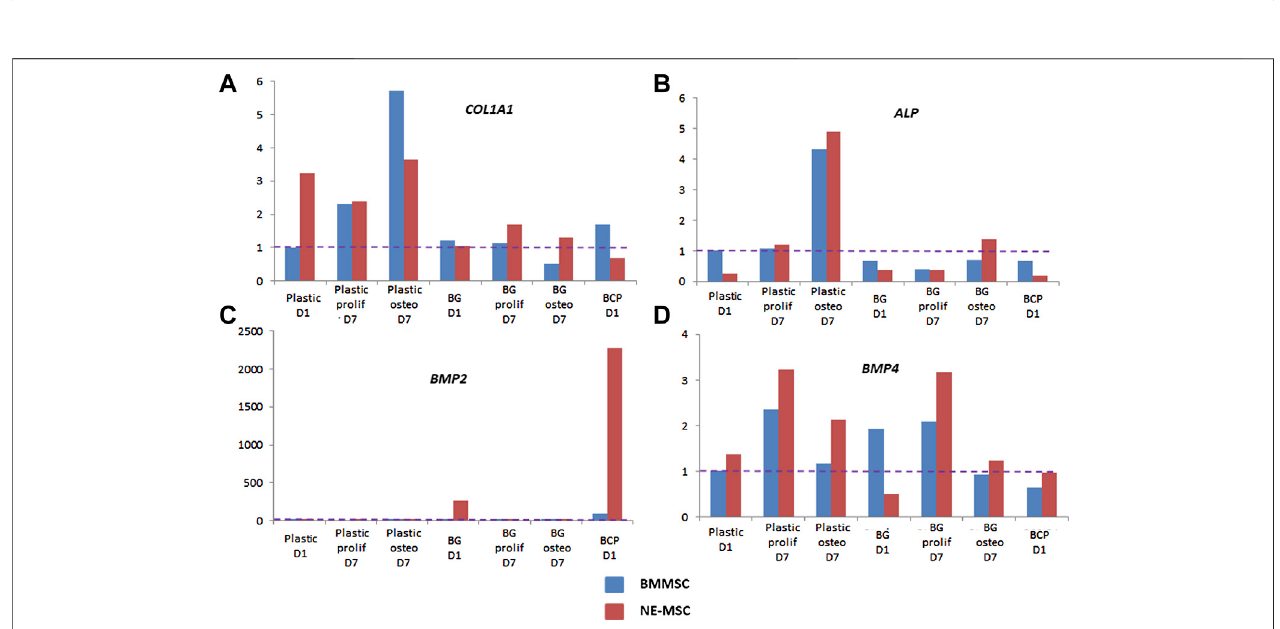
FIGURE 8 | Expression of other ossi fi cation-related genes- COL1A1 (A) , ALP (B) , BMP2 (C) , and BMP4 (D) -was measured by RTqPCR for each cell type on plastic, BG and BCP biomaterials. No data at D7 on BCP was obtained because the cells did not proliferate and the amount of RNA was too small.